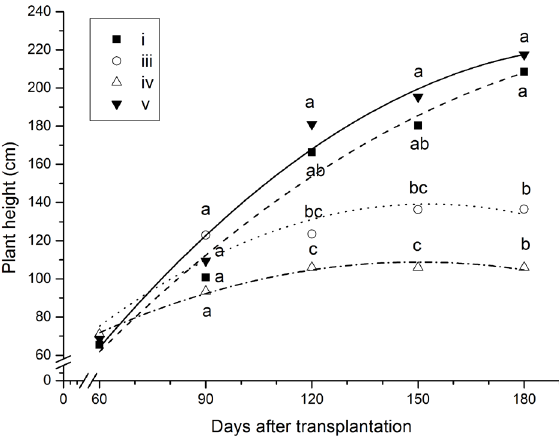
Figure 2 - Intercropping effects on sugarcane plant height: (i) sugarcane monocropping, iii) sugarcane cropping intertwined with morning glory but in separate boxes, (iv) sugarcane cropping intertwined with morning glory in attached boxes and (v) sugarcane intercropping with morning glory in attached boxes without intertwining with the sugarcane. Means followed by the same letter in each period are not different from one another at 5% probability according to Tukey’s